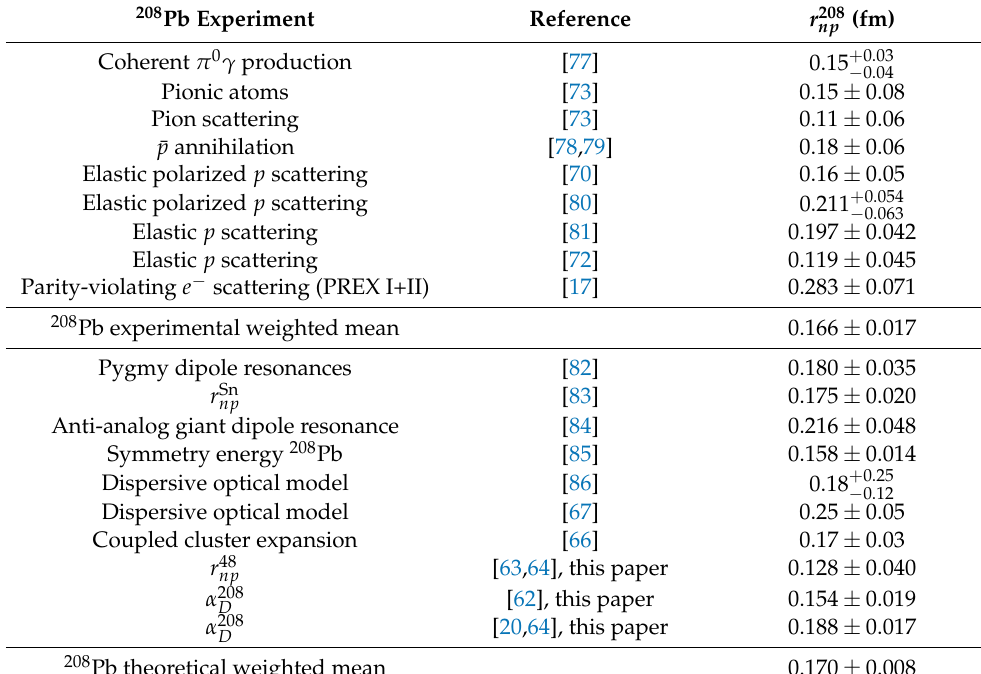
Table 4. 208 Pb neutron skin measurements and theoretical predictions with 1 σ uncertainties